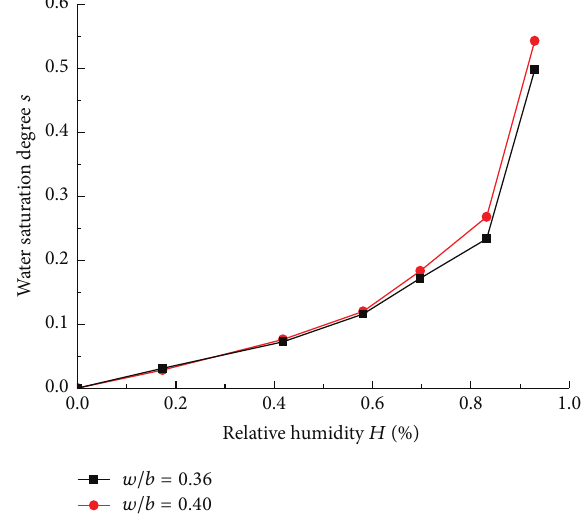
Figure 1: Isothermal adsorption curves for the concrete mixtures.